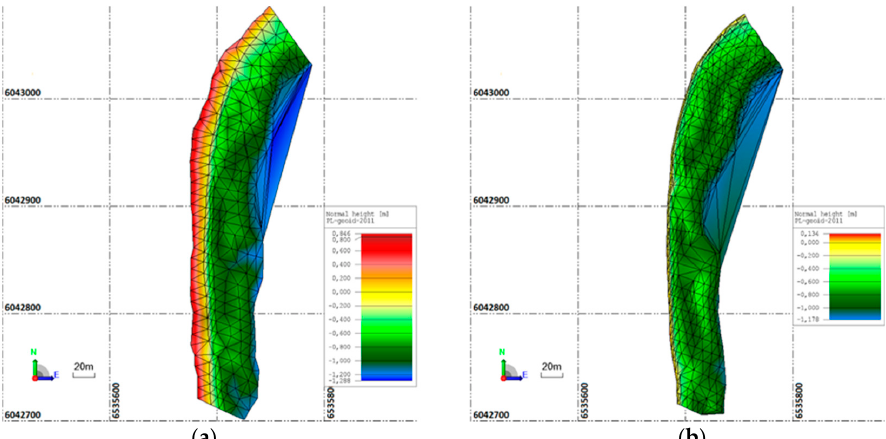
Figure 4. Digital Terrain Models (DTM) of the waterbody adjacent to the municipal beach in Gdynia acquired by the geodetic method in 2016 ( a ) and 2018 ( b ). acquired by the geodetic method in 2016 ( a ) and 2018 ( b